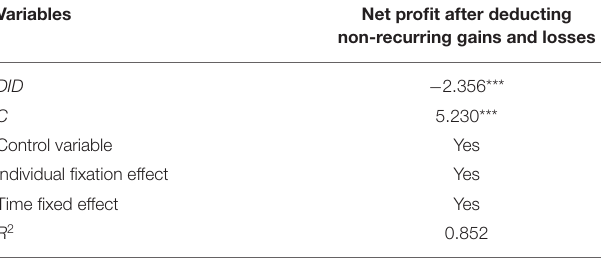
TABLE 4 | Robustness